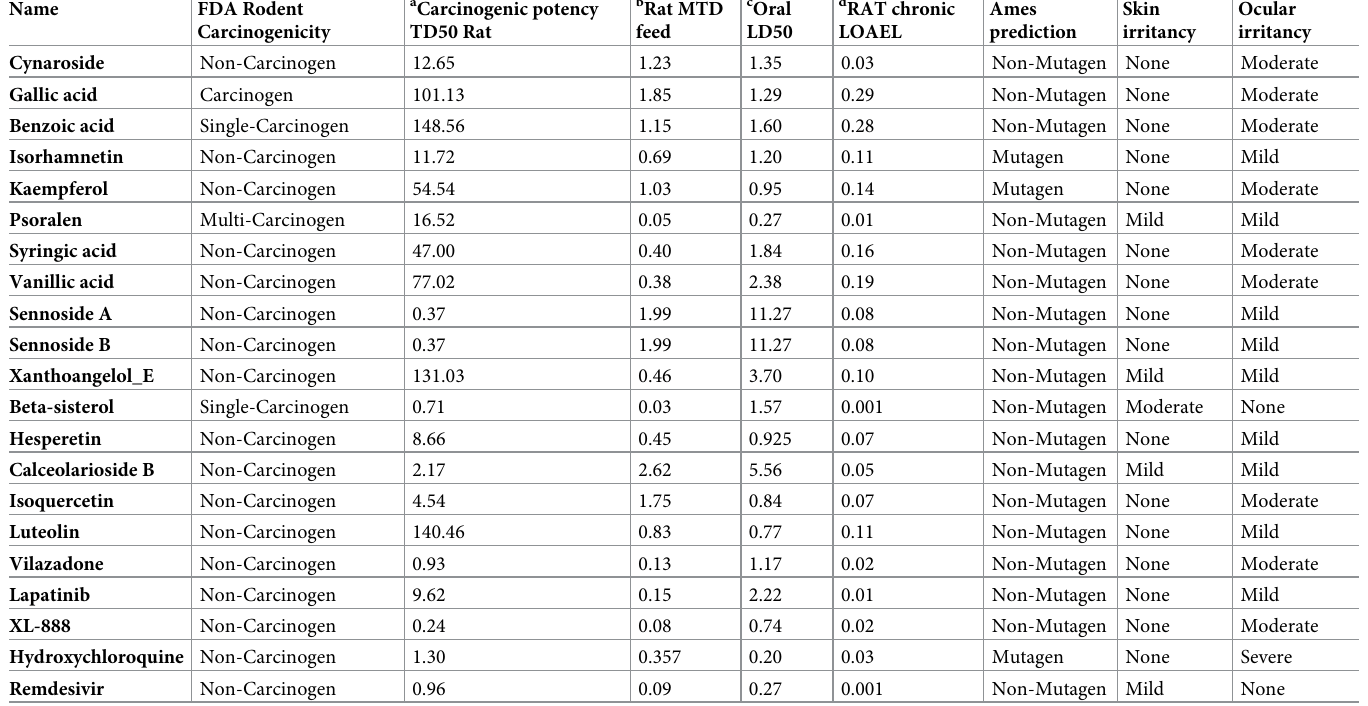
a Tumorigenic dose rate 50 TD50 in unit mg/kg body weight b Maximum tolerated dose MTD in unit g/kg body weight c Median lethal dose LD50 in unit g/kg body weight d Lowest observed adverse effect level LOAEL in unit g/kg body